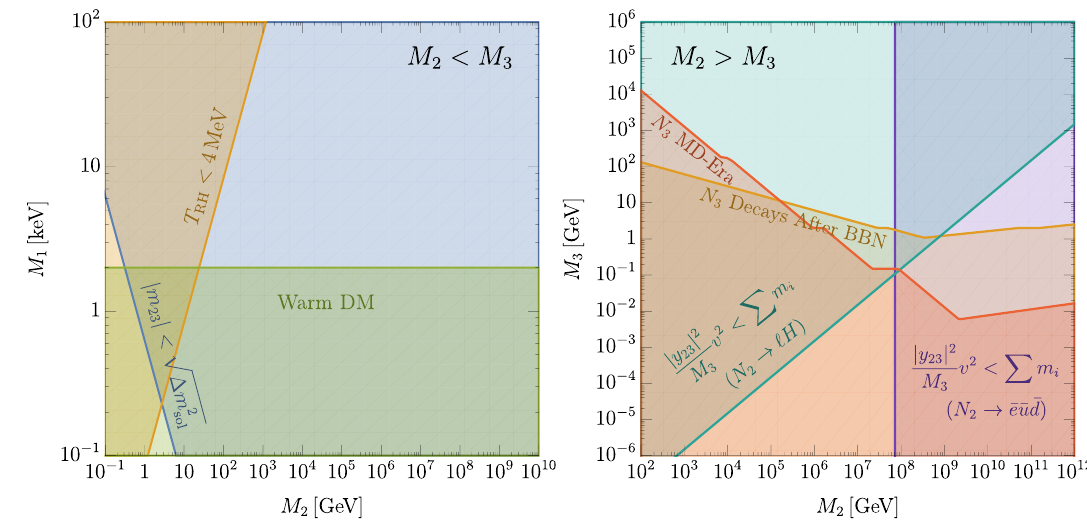
Figure 5 . The right-handed neutrino mass parameter space showing the constraints which prove Claim 1 and Claim 2 . Left : M 2 < M 3 (Case 1) | the relation M 2 = m 2 ( v R =v ) 2 =c is guaranteed p p if j m 23 j < (cid:1) m sol2 . Stability of N 2 ensures j m 23 j < (cid:1) m 2 in blue , which encompasses all of sol the parameter space not excluded by the warmness of DM ( green ) or Big Bang Nucleosynthesis ( orange ). Right : M 2 > M 3 (Case 2) | the relation M 2 = (cid:22) ( v R =v ) 2 =c , where 0 : 01 eV . (cid:22) . 0 : 10 eV, is guaranteed if j y 23 j 2 v 2 =M 3 < P m i . Stability of N 2 ensures j y 23 j 2 v 2 =M 3 < P m i in the purple and turqoise regions which encompass all of the parameter space not excluded from N 3 decaying after Big Bang Nucleosynthesis ( orange ). N 3 disrupts Big Bang Nucleosynthesis from the energy released in its decays when M 3 > 1 MeV in the orange region, and from the entropy produced from its decays in the intersection of the orange and red